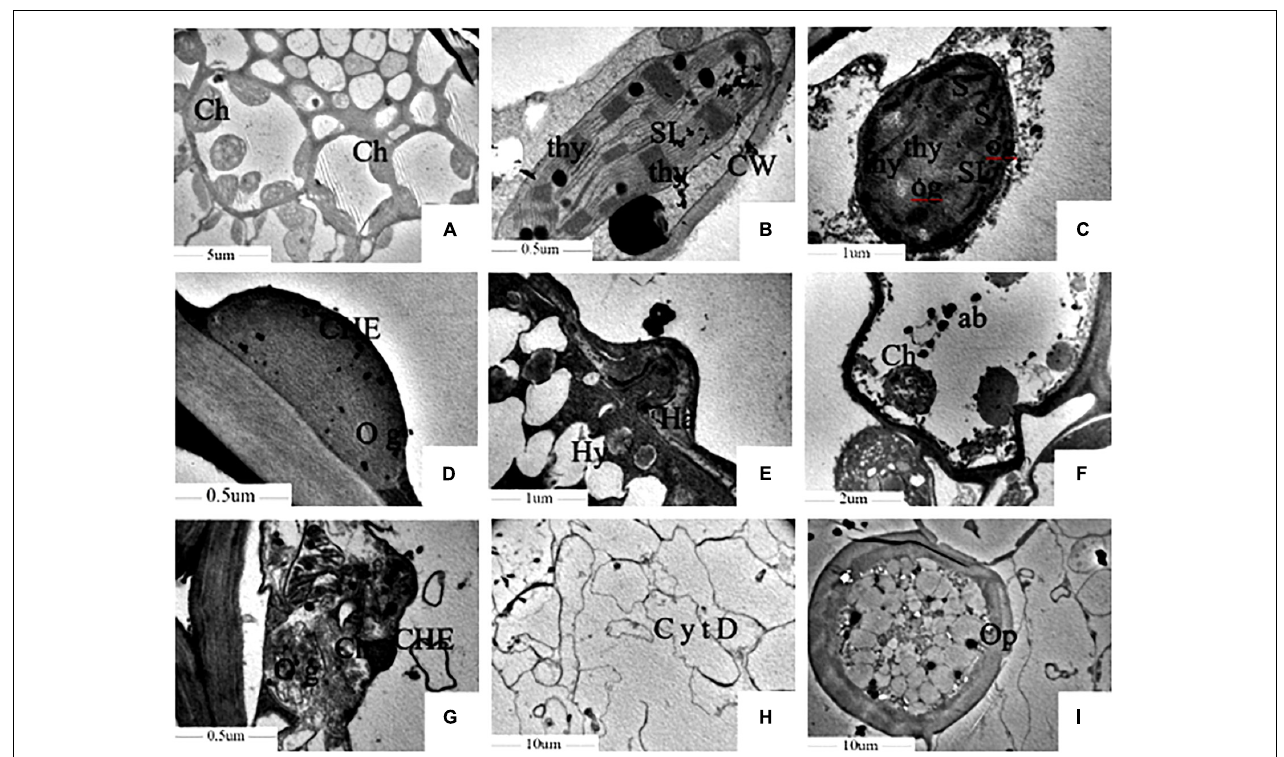
FIGURE 3 | Sclerospora graminicola inhibited the development of chloroplast of foxtail millet. (A,B) Are uninfected leaves; (C–I) are infected leaves. Ch, chloroplast; thy, thylakoid; SL, stromal lamella; Hy, mycelium; Ha, haustorium; S, starch granule; og, osmiophilic granule; ab, apoptotic corpuscle; Op, oospore; CW, cell wall; CHE, chloroplast membrane; CytD, cytoplasmic degradation.